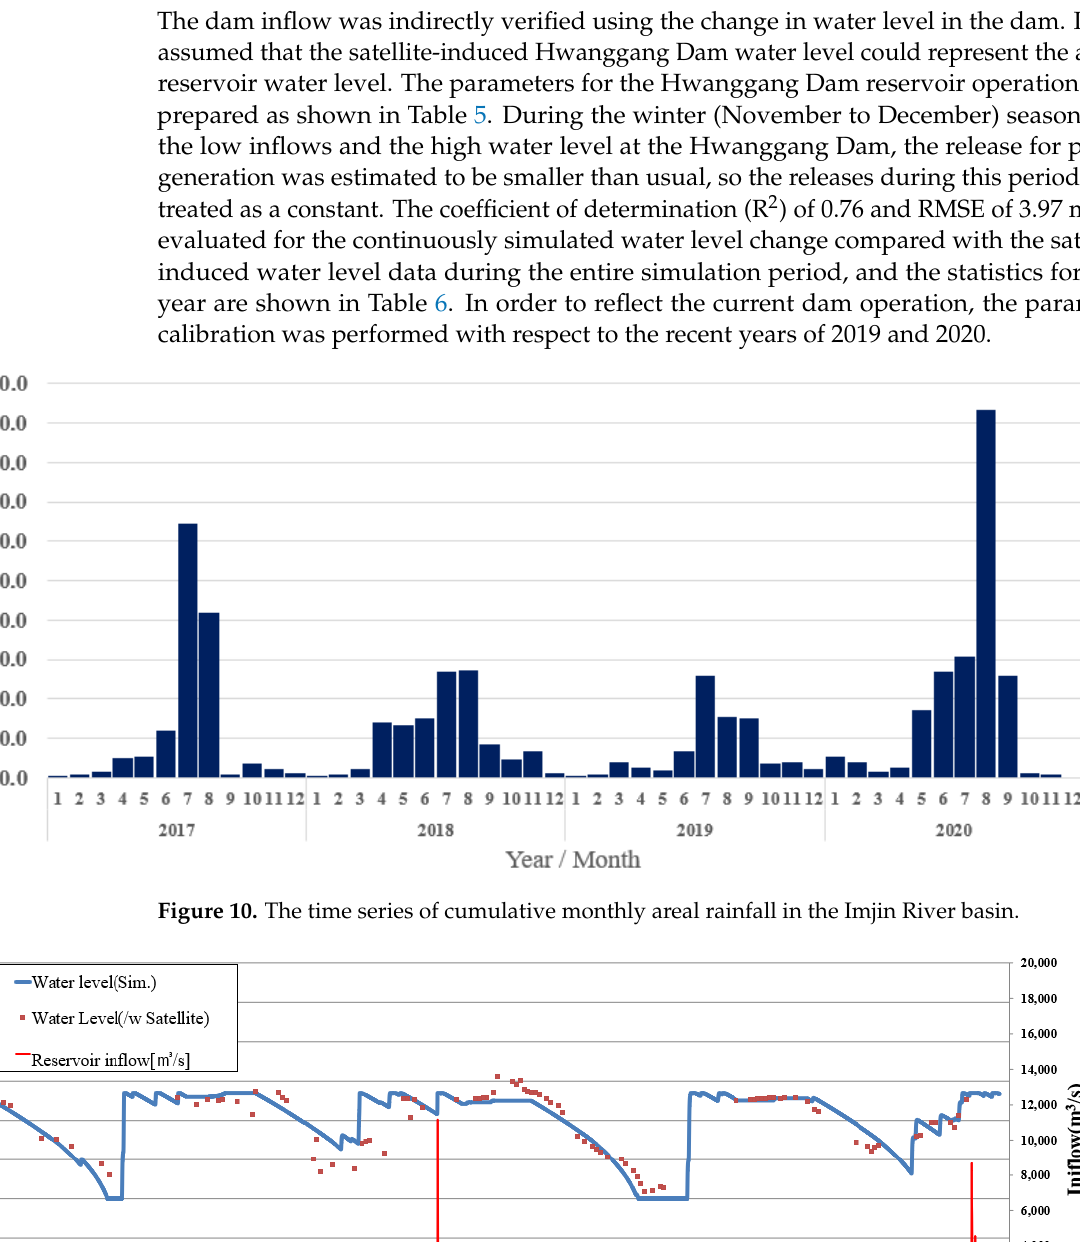
Figure 9. The flow chart of the Auto ROM algorithm for the Hwanggang Dam reservoir.